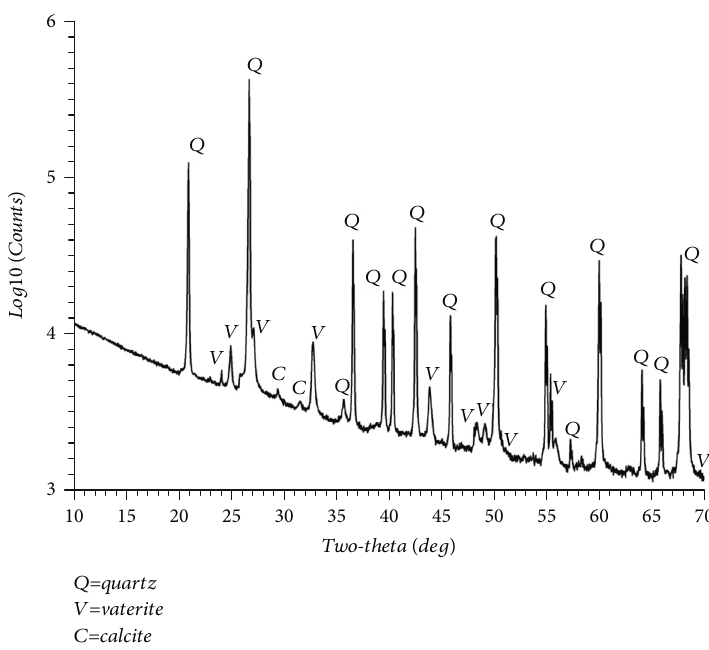
Figure 5: Mineral composition of the biotreated sample recovered from X-ray di ff raction (XRD).